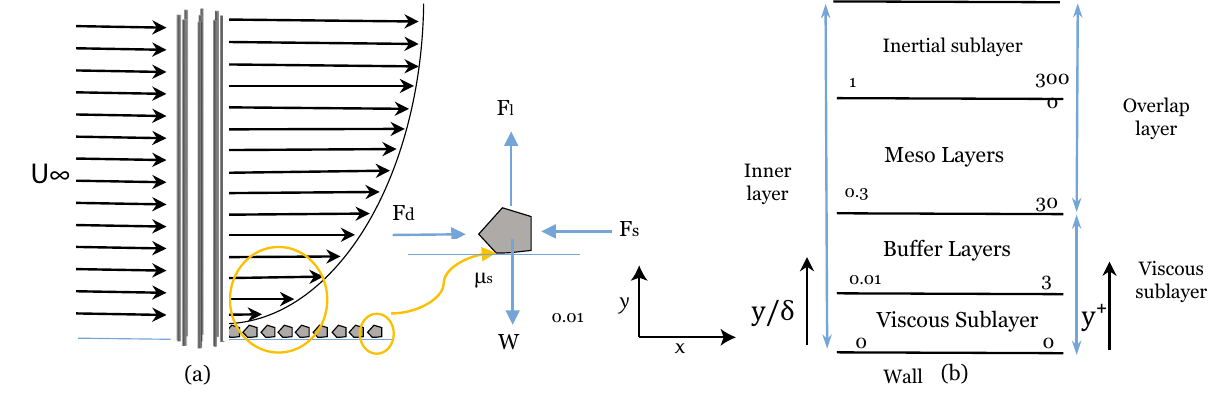
Figure 11. ( a ) Velocity profile over the bed with the presence of a mangrove root model that produces large roughness as the boundary layer is formed with thickness δ ; The interacting forces on arbitrary sediment are drag and lift forces that encourage incipient motion and sediment weight force that resist the motion. Sediment transport begins when the combined lift and drag forces produced by the fluids become large enough to counteract the gravity and frictional forces that hold the sediments in place. Since the mangrove models generate a turbulent boundary layer, a turbulence-based model can predict the incipient motion. ( b ) The structure of a turbulent boundary layer for smooth surfaces based on wall-normal distance ( y + = yU τ ν